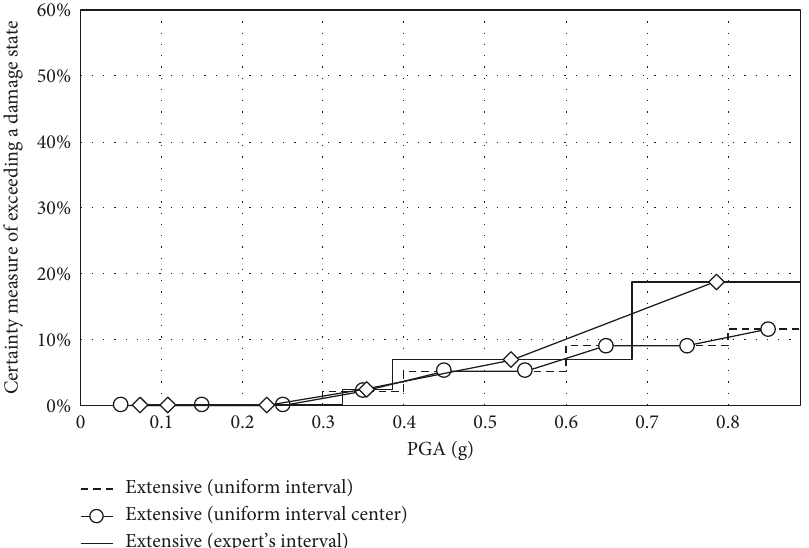
Figure 13: Comparison of the proposed fragility curves for Extensive about the different interval selections with alternative formulation of the proposed fragility curves by using step function and connecting the necessity measure at the center of PGA